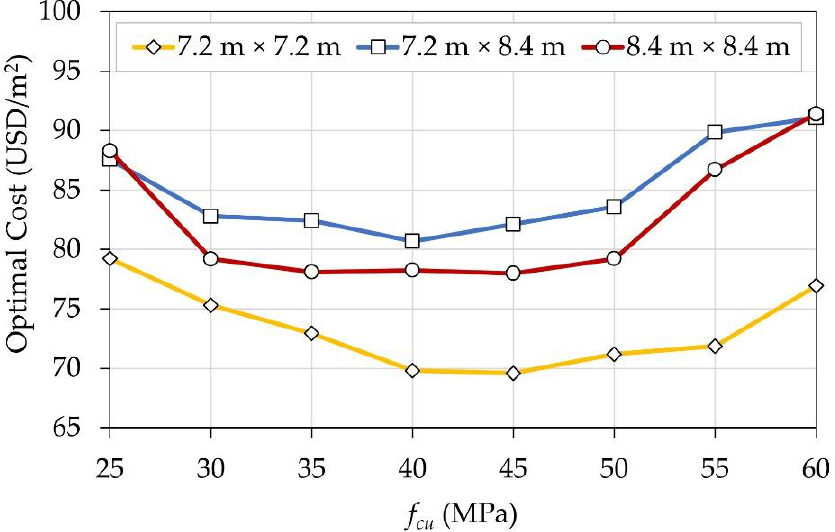
Figure 12. Comparison between FSWD design alternatives.